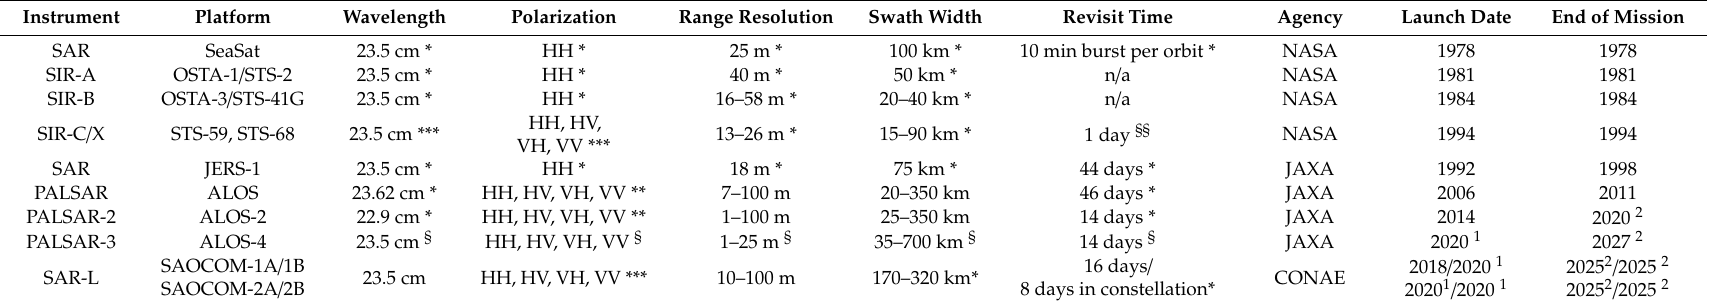
Table 2. Spaceborne L-band SAR imaging systems. Data sources: (1) Observing Systems Capability Analysis and Review Tool (OSCAR), developed by the World Meteorological Organization (WMO); (2) Earth Observation Data Portal (developed by ESA). H: horizontal and V: vertical